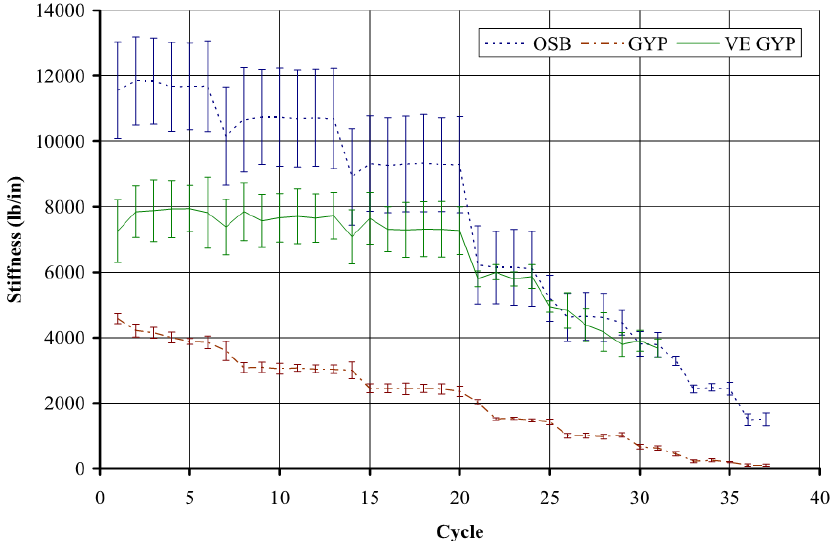
Figure 11. Average stiffness vs. cycle number for all walls.